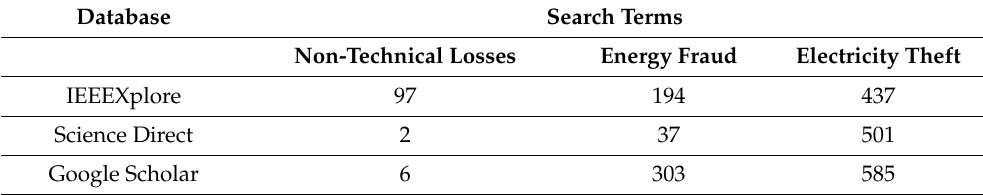
Table 1. Search results for each database.